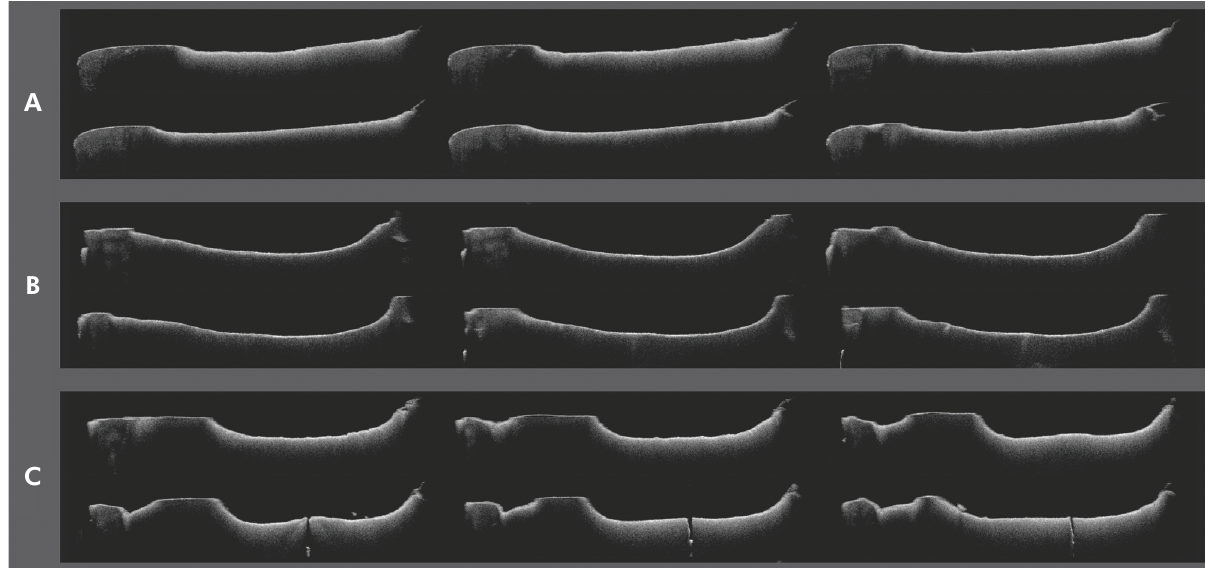
Figure 2. Sequential images obtained by OCT of a specimen allocated to the selective carious tissue removal protocol after caries induction (A), and the non-selective carious tissue removal protocol after caries induction and softened dentin removal with an excavator (B and C). Note the pulp chamber exposure due to the deep cavity obtained in C.